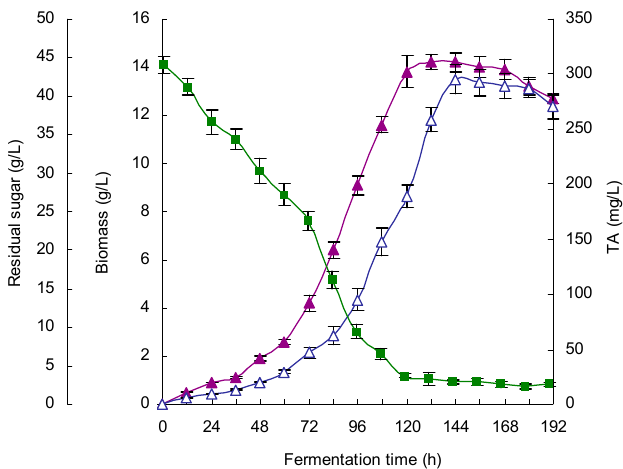
Figure 5. Time profiles of sugar consumption ( ■ ), mycelial growth ( ▲ ) and mycelial triterpene acid (TA) production ( △ ) by Ganoderma lingzhi under the optimized fermentation conditions in a 200-L stirred-tank bioreactor. Medium volume, 140 L; initial pH, 5.9; DO, ~20%; temperature, 28.6 °C; aeration rate, 0.7 vvm; culture time, 8 days